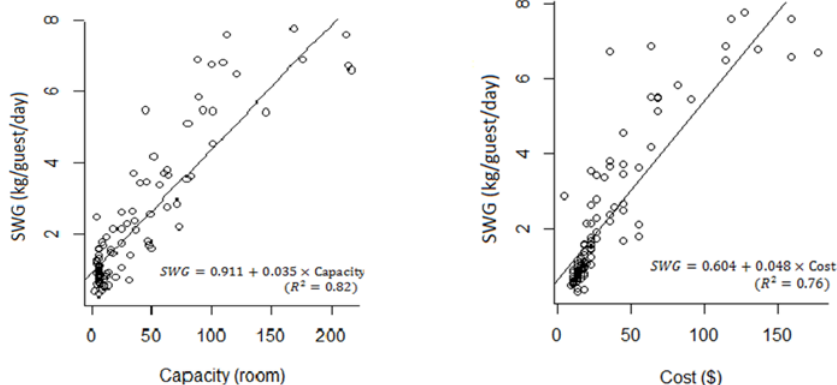
Fig. 6: Correlation between Capacity or the price of the room and solid waste generation rate in the hotels